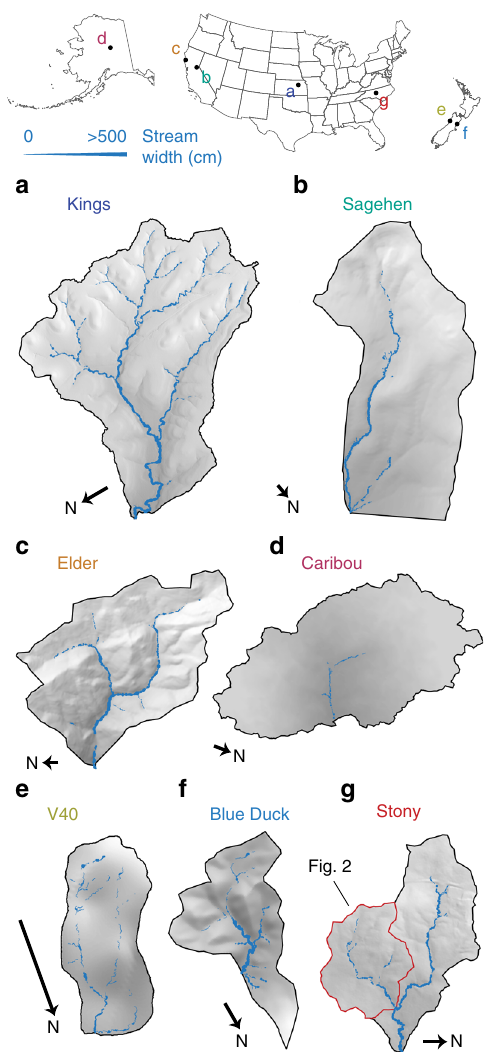
Fig. 1 Stream width maps in study catchments. a K1B tributary, North Branch of Kings Creek, KS; b Sagehen Creek Subcatchment, CA; c Upper Elder Creek, CA; d C1 tributary of Caribou Creek, AK; e V40 Stream Subcatchment, NZ; f Blue Duck Creek Subcatchment, NZ; g Stony Creek Research Watershed, NC. Lengths of north arrows represent 200